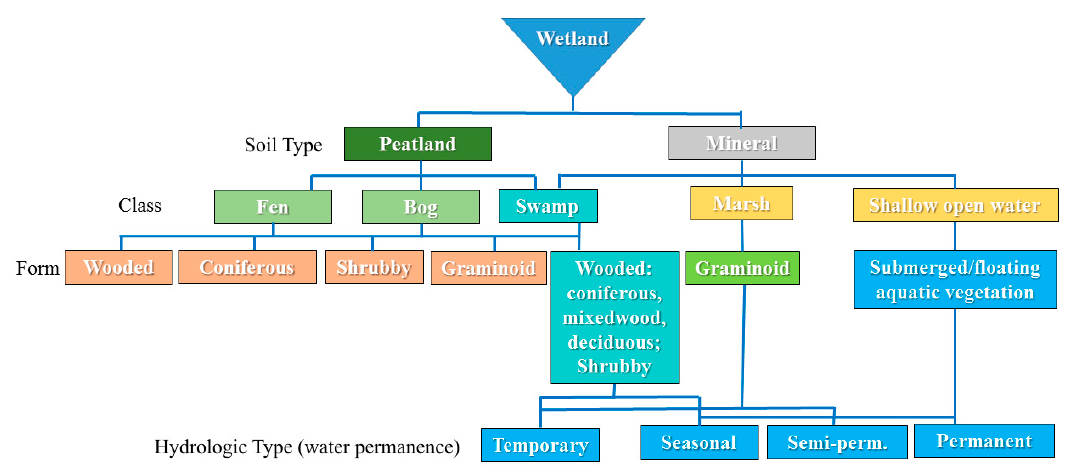
Figure 7. Hierarchical classification framework for wetland class, soil type, form, and hydrologic type (water permanence) for boreal and foothills biomes of Canada (adapted from References [258,261]).